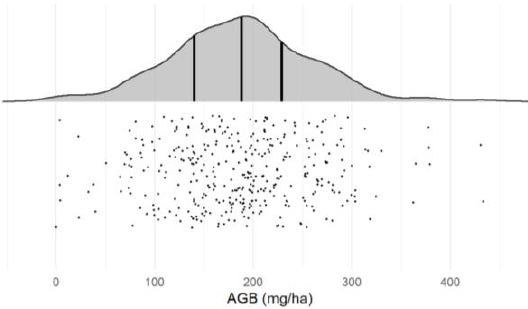
Table 4 . Results of HWF AGB estimation for RF and Figure 2 . Distribution of calculated AGB using CRM LightGBM using airborne LiDAR, Landsat 5, ALOS PALSAR, allometric equations. The grey dots represent a cloud of randomly jittered plots below the ridge line plot. The AGB values of sample plots were used to train and test the models based on 70/30 split